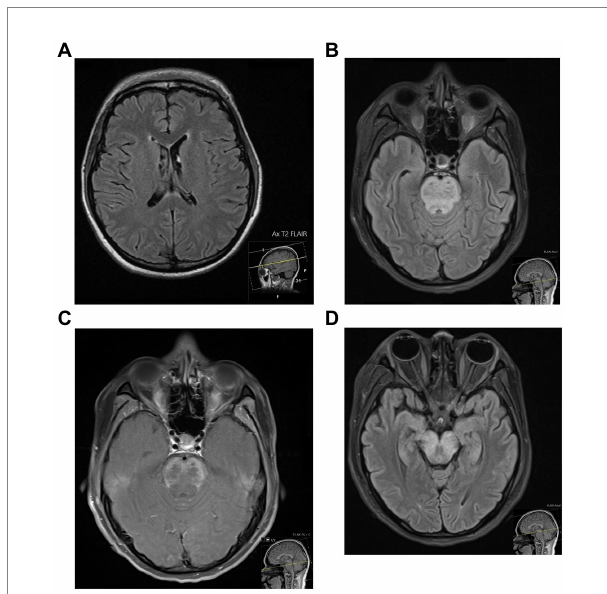
FIGURE 1 Two patients with NPSLE, who both presented with seizures in the context of a systemic hyperinflammatory syndrome. The transaxial MRI FLAIR of the first patient (A) , a 27-year old female, was unremarkable. The MRI of the second patient (B–D) , a 20-year old female, showed diffuse swelling of the pons with increased T2/FLAIR signal (B) and diffuse peripheral abnormal contrast enhancement (C) , with extension of the T2/FLAIR signal inferiorly to the lower medulla and superiorly across white matter tracts of the midbrain (D) – all of which were in keeping with a severe CNS